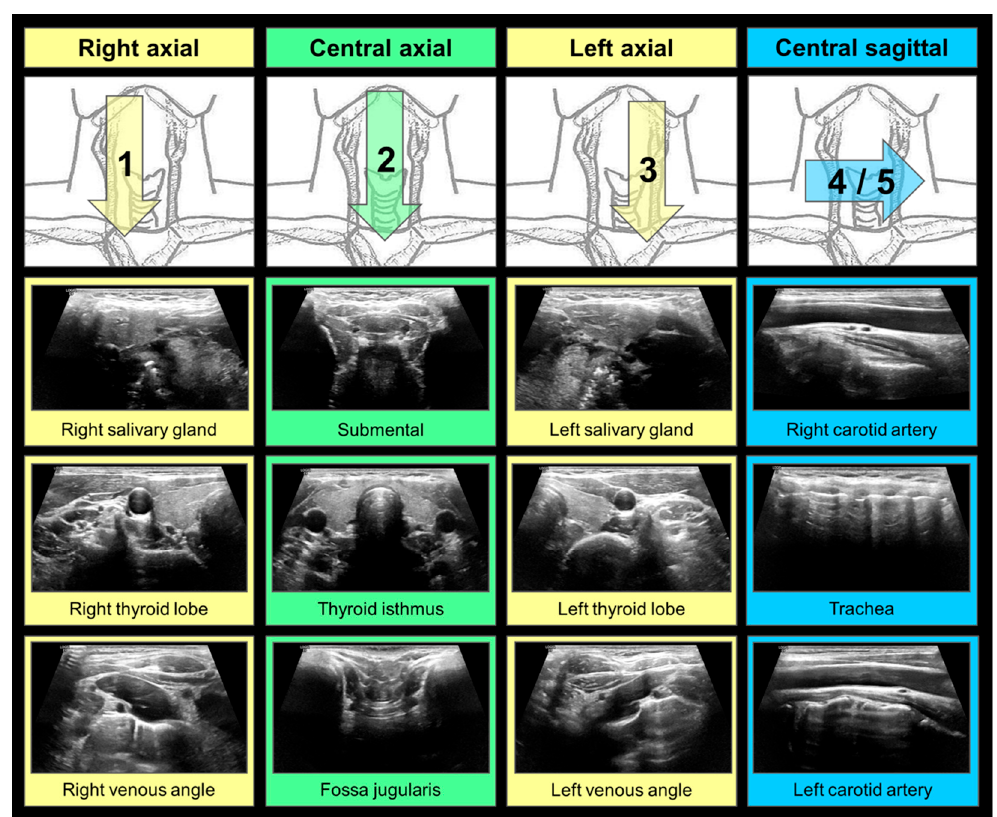
Figure 1. Ultrasound (US) cine loop standard operating procedure (SOP) for benign thyroid diseases. A total of four to five cine loops should be acquired. (1,3): Axial scans of the right/left cervical compartment for the depiction of the right/left thyroid lobe, extending from the submandibular salivatory glands (cranial reference organs, starting point) to the brachiocephalic venous angles (caudal reference structures, endpoint). (2): Axial scan of the central cervical compartment for the depiction of the thyroid isthmus, extending from submental (cranial reference structure, starting point) to the jugulum (caudal reference structure, endpoint). (4/5): Sagittal scans of the central cervical compartment covering the whole extent of both thyroid lobes and the isthmus, extending from the right carotid artery (right lateral reference structure, staring point) via the trachea (median reference structure) to the left carotid artery (left lateral reference structure, endpoint); depending on the shape of the larynx, two separate scans may be favorable.